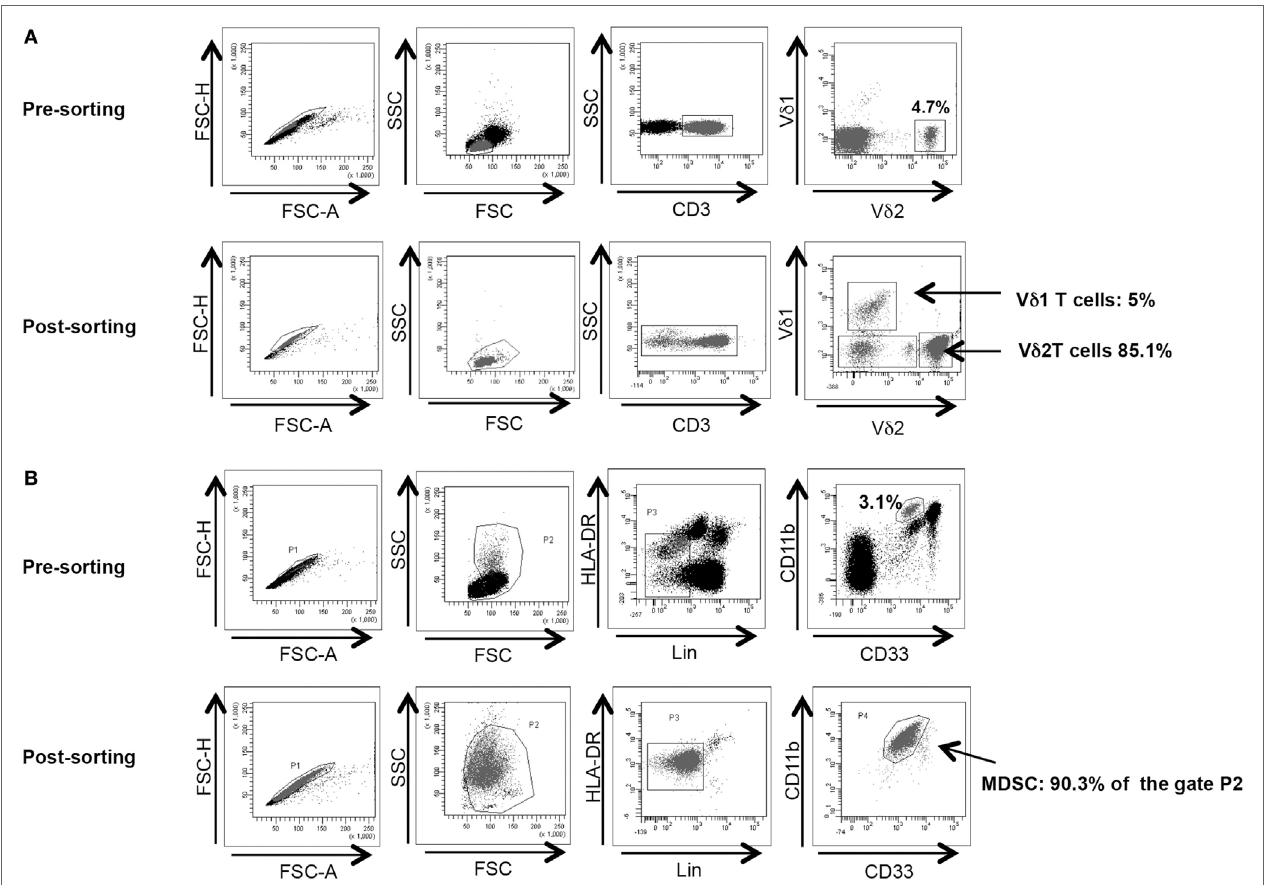
FigUre 1 | γδ T cell and PMN-myeloid-derived suppressor cells (MDSC) purity after magnetic sorting. (a) Representative purity of γδ T cells before and after sorting. Gating strategy is shown. (B) Representative purity of PMN-MDSC before and after sorting. Gating strategy is